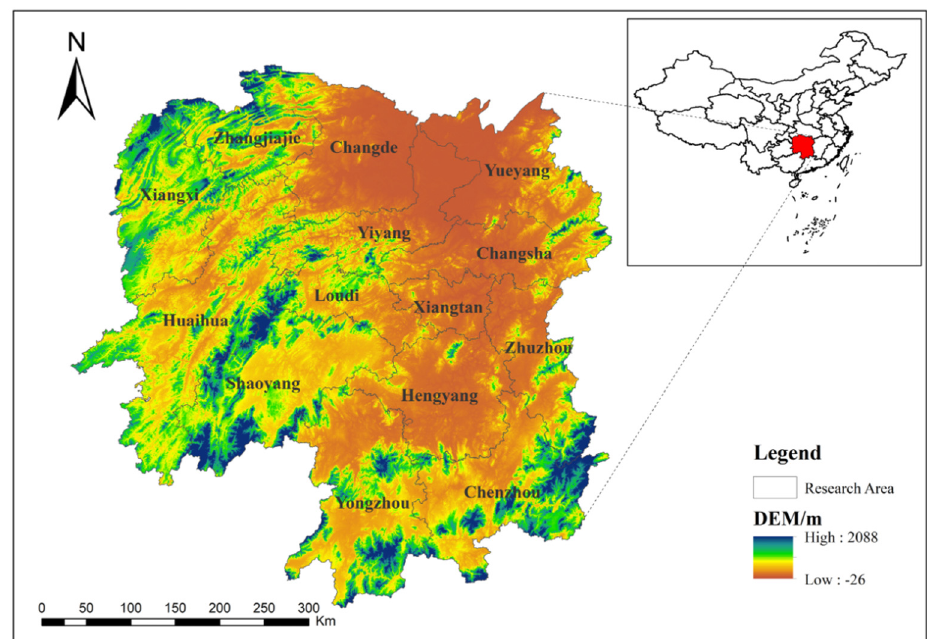
Figure 1. The geographical location of Hunan